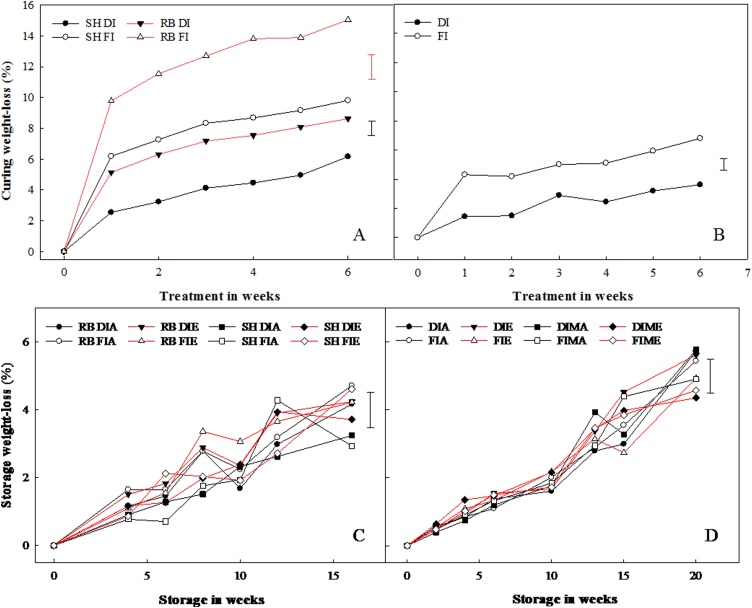
Postharvest curing weight-loss (A and B) and storage weight losses (C and D) in stored onion bulbs. Onion bulbs of cultivar ‘Red Baron’ (RB) and ‘Sherpa’ (SH) were grown in 2015 (A and C) and 2016 (B and D) under full irrigation (FI) or deficit irrigation (DI); where FI amounted to 100% replenishment of crop evapotranspiration (ETc) and DI was ETc replenishment at 50%. Bulbs were harvested at full maturity (100% fall-down) and cured under glass for six weeks for both years. Post-curing, bulbs were either treated with 1-MCP at 1 μL L−1 for 24 h or untreated before storage; and then, stored at 1 °C under continuous ethylene supplementation at 10 μL L-1 or air. DIA and FIA are DI and FI bulbs in air, DIE and FIE are DI and FI bulbs stored under ethylene, DIMA and FIMA are DI and FI bulbs treated with 1-MCP and stored in air and DIME and FIME are DI and FI bulbs treated with 1-MCP and stored under ethylene. LSD bar at 95% confidence shown.